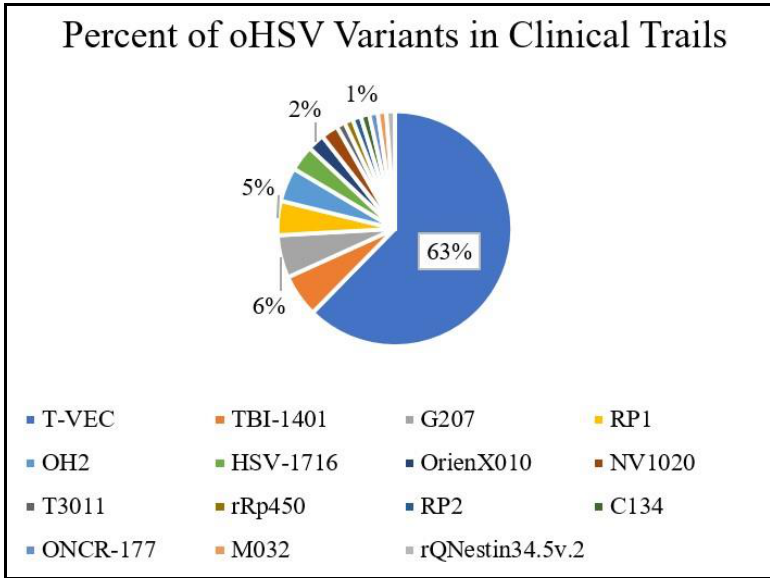
Figure 2. A summary of clinical trials registered at ClinicalTrials.gov involving oHSV variants. Access date: 13 February 2021.